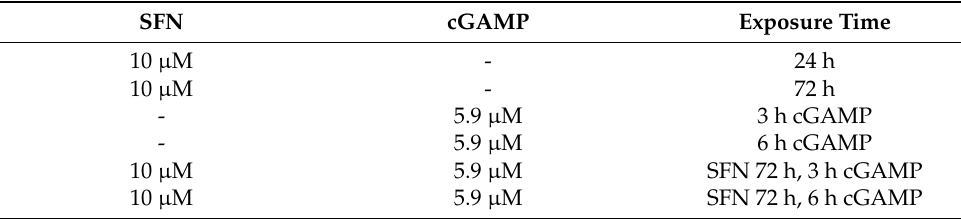
Table 5. Different combination treatment of SFN and cGAMP used on the IHH cell